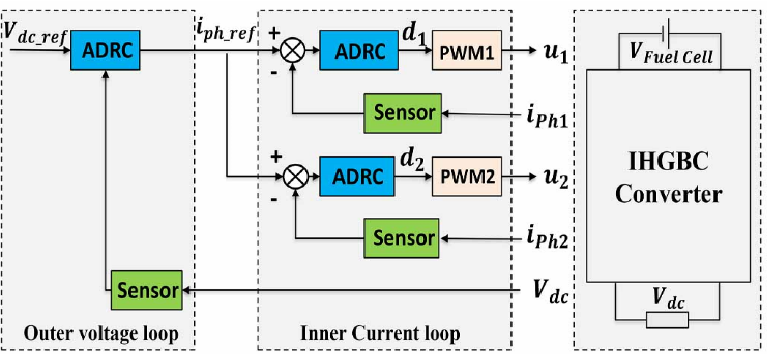
Figure 3. Cascaded control scheme for IHGBC.